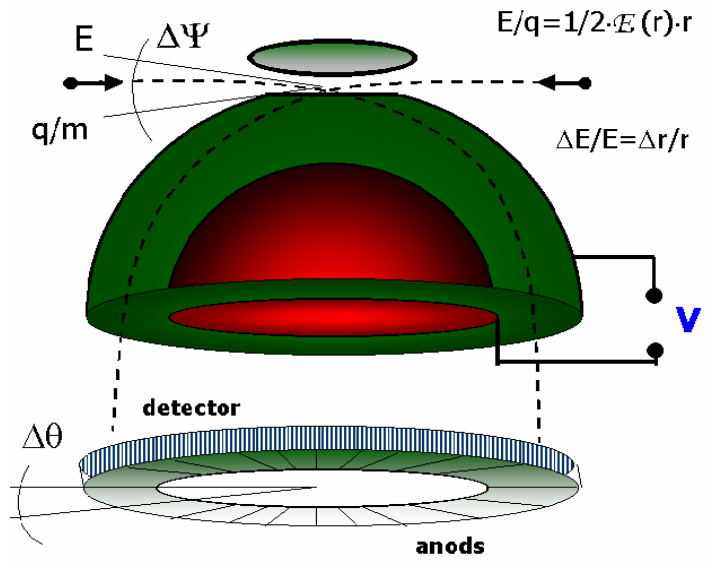
Figure 121: Outline of a top-hat plasma